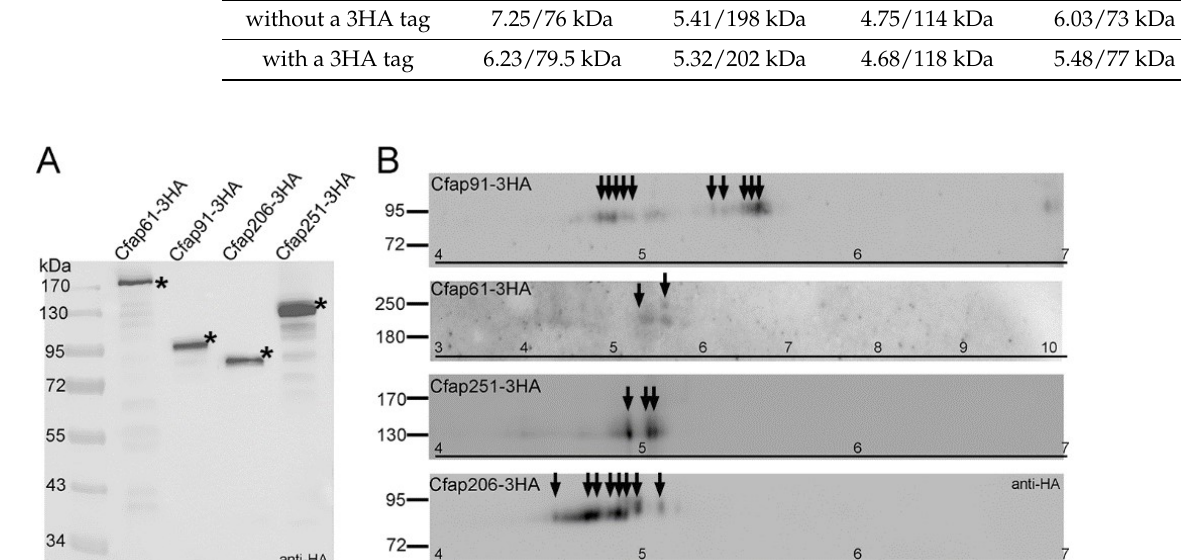
Figure 8. Proteins building the base of RS2 and RS3 are present in cilia in more than one isoform. ( A ) The Western blot analyses of ciliary proteins isolated from cells expressing C-terminally 3HA tagged Cfap61, Cfap91, Cfap206, or Cfap251 under the control of the respective native promoters. Stars indicate the position of the band of expected size. Weakly visible bands of lower molecular weight are products of protein degradation. ( B ) Two-dimensional analyses of axonemal proteins purified from cells expressing -3HA fusion proteins under the control of the respective native promoters. Isoelectric focusing was performed using 7 cm 4–7 or 3–10 ready-strips. The theoretical pI and Mw were calculated using https://web.expasy.org/compute_pi (accessed on 10 October 2022) (Table 3). Black arrows indicate detected isoforms. Whole blots are presented in Figure S4. Table 3. Calculated theoretical pI and Mw of analyzed proteins Calculated pI/Mw: